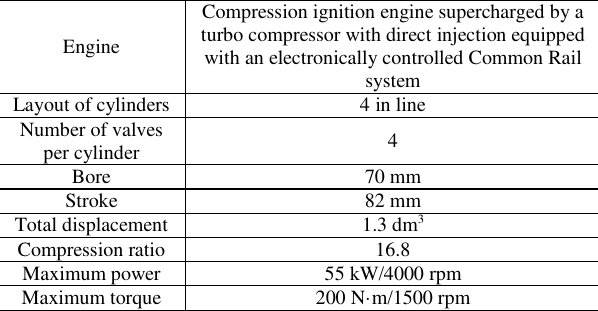
Table 1. The engine’s technical data